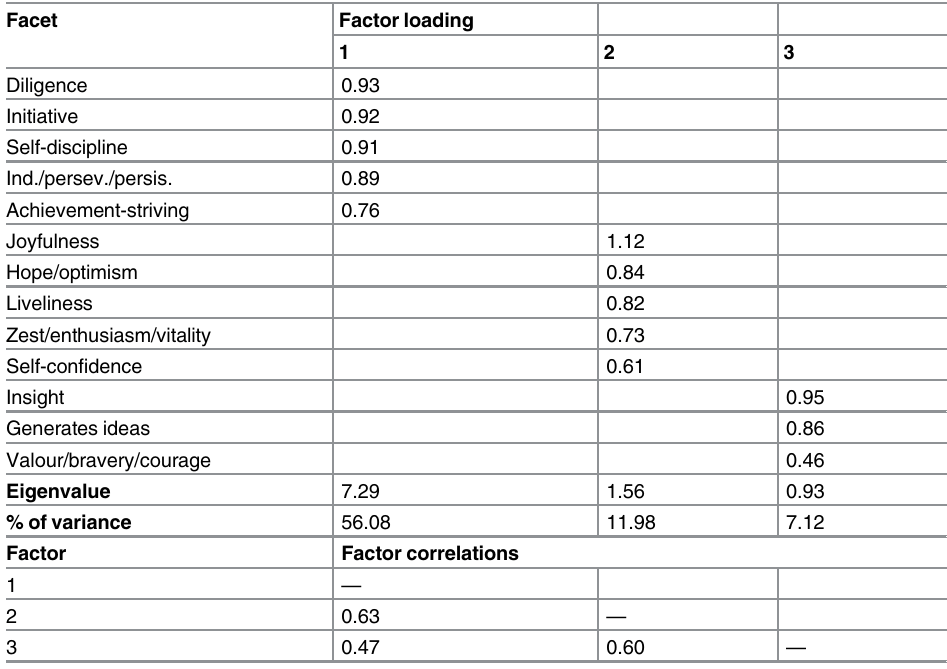
N = 362. Factor loadings of < .30 are omitted from the table. IPIP = International Personality Item Pool; Ind./ persev./persis. =